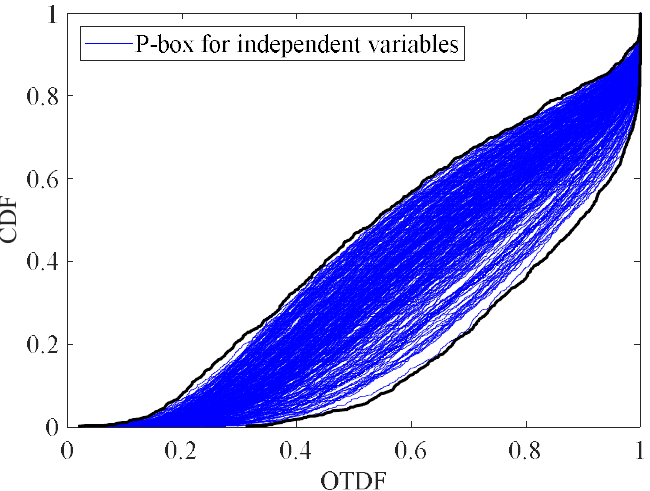
Figure 16. The p−box for OTDF with independent variables after affine transformation. Figure 16. The p-box for OTDF with independent variables after affine